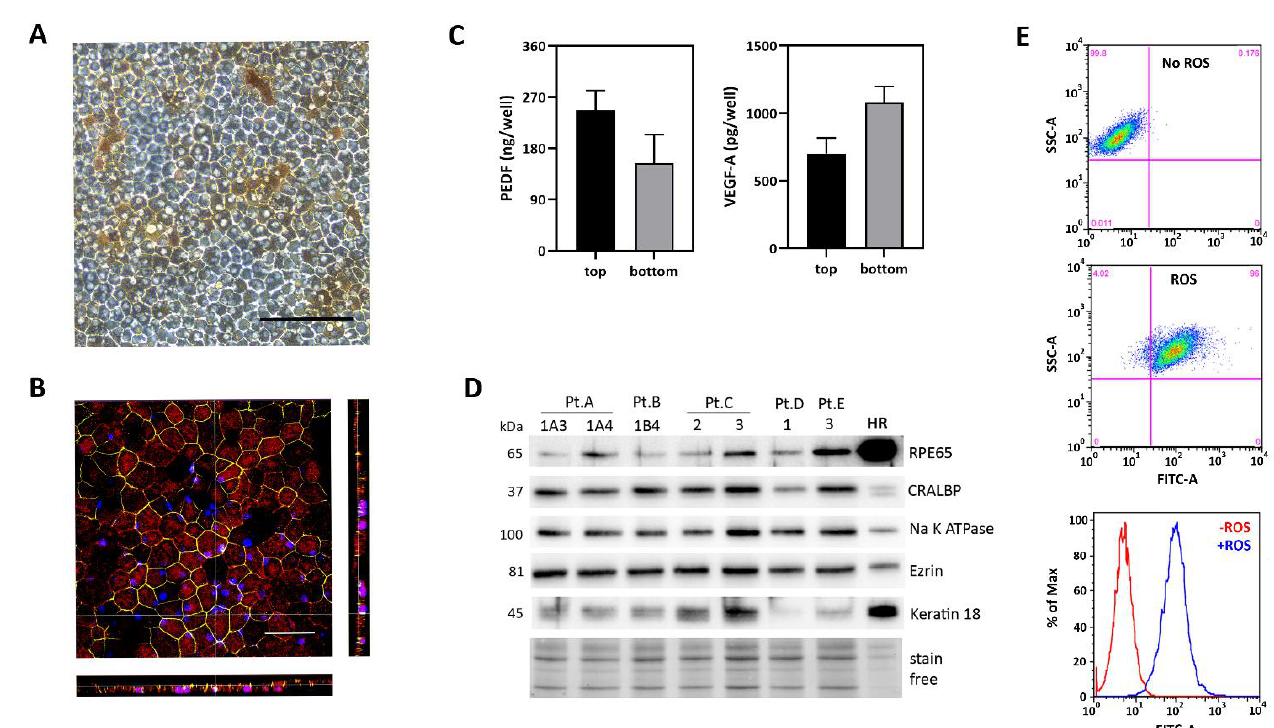
Figure 2. iPSC-RPE derived after reprogramming conjunctival cells obtained from patients with AMD. ( A ) Phase microscopy image showing that confluent iPSC-RPE lines form a monolayer with cobblestone appearance and have pigmentation. Scale bar = 100 µm. ( B ) Confocal microscopy image of iPSC-RPE cultured on a transwell insert. En face views of the RPE monolayer shown as maximum intensity projection through the z-axis. Bestrophin (red) is expressed on the basal surface. ZO-1 (green) marks cell borders. Nuclei are stained with DAPI (blue). Scale bar = 40 µm. ( C ) Results from ELISA analysis of pigment epithelium-derived factor (PEDF) and vascular endothelial growth factor A (VEGF-A) content measured in apical (top) and basal (bottom) media from iPSC-RPE ( n = 5) grown on transwells. Mean ± SEM. ( D ) iPSC-RPE cultures express prototypic RPE proteins as demonstrated on Western immunoblots. Molecular mass for each protein is shown on the left. HR is a homogenate of RPE tissue from a human donor. Stain-free image is loading control. ( E ) Representative data from FACS analysis measuring the phagocytosis of FITC-labeled OS by RPE. Dot plots and histograms for cells without and with the addition of OS are shown.